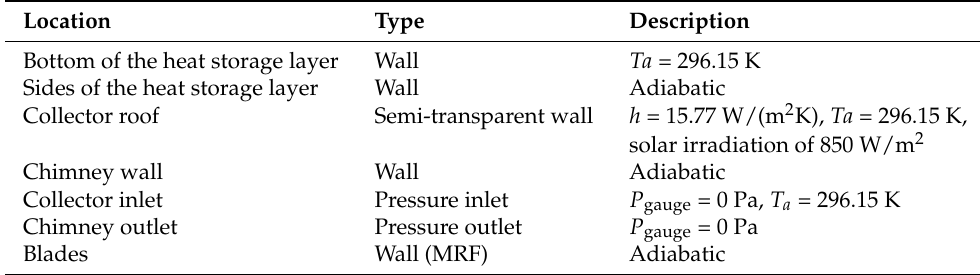
Table 2. Boundary